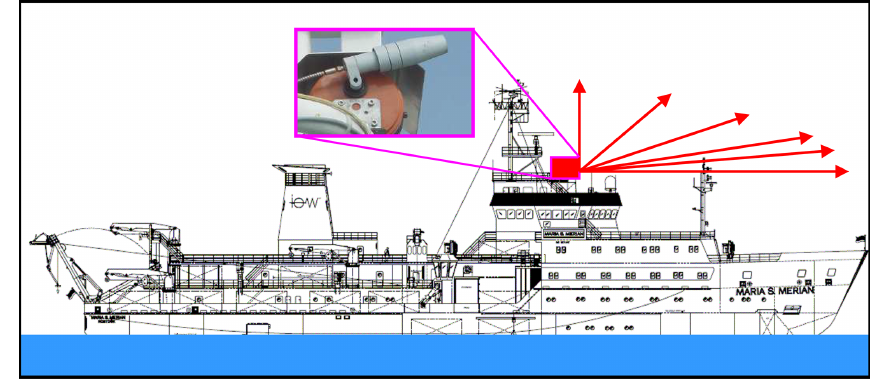
Figure 2. The position and viewing direction of the MAX-DOAS instrument on the RV Maria S. Merian during the ship cruise (ship drawing taken from https://briese-research.de/research-department/research-vessels/rv-maria-s-merian, last access: 1 May